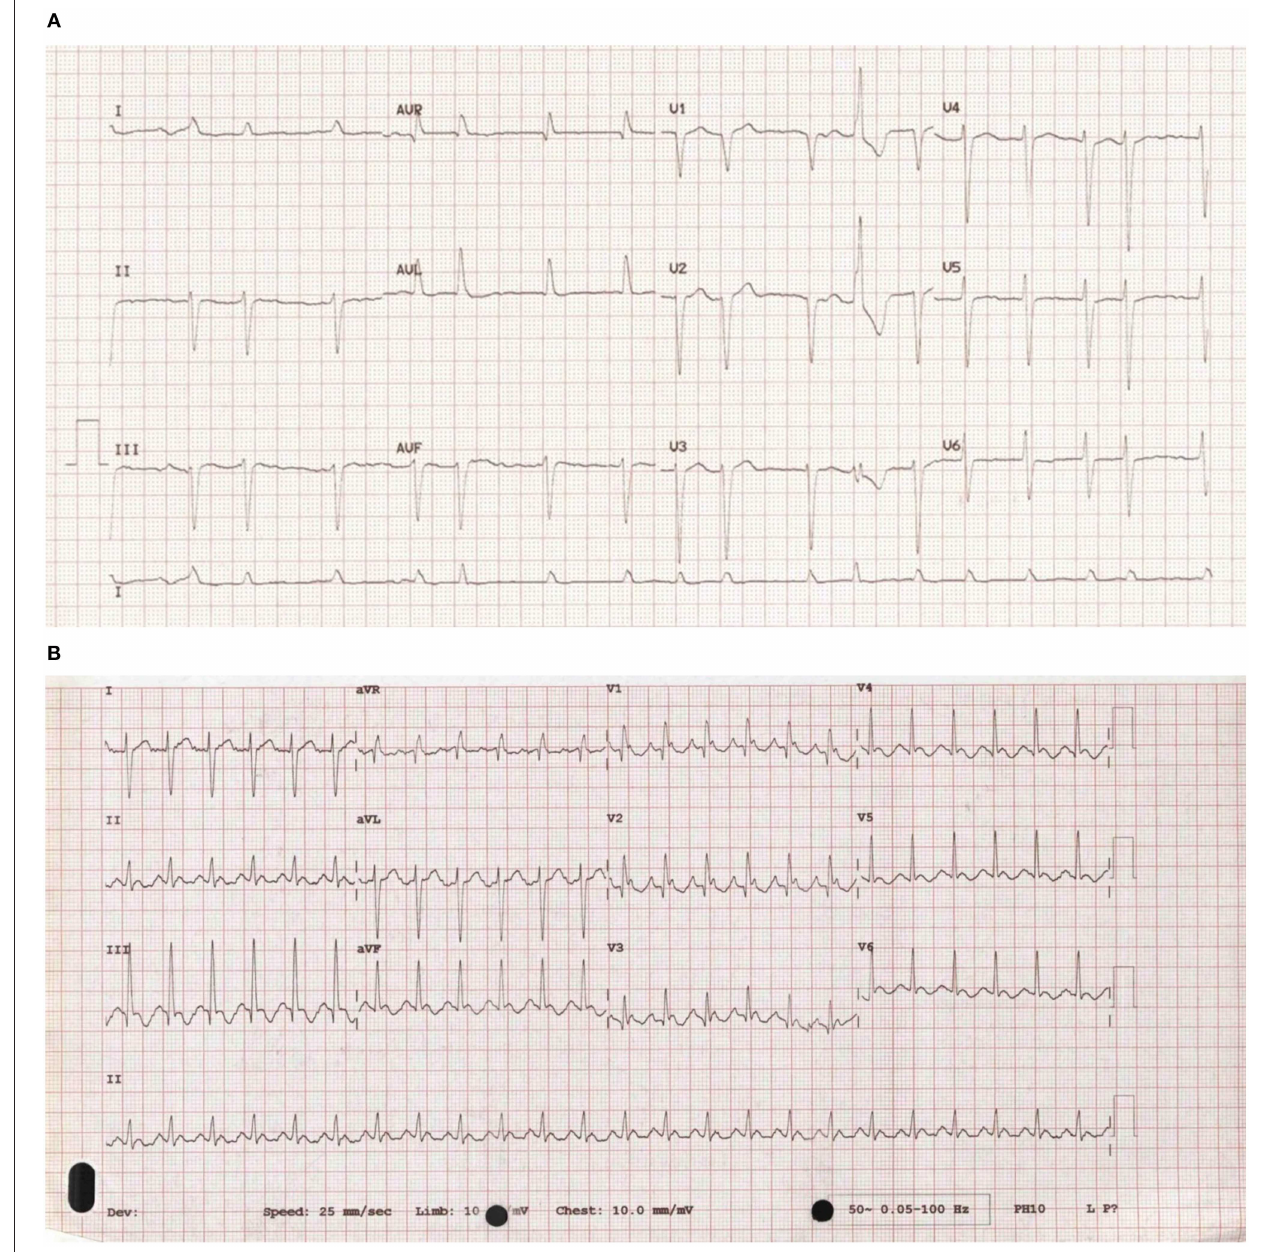
FIGURE 1 | (A) An ECG of atrial fibrillation. An example of an ECG taken from a patient with atrial fibrillation showing uncoordinated atrial activity resulting in an irregular ventricular rate. (B) An ECG of atrial flutter. An example of an ECG taken from a patient with atrial flutter. It is characterized by rapid, regular atrial depolarizations (typically, but not always at a rate of 300 bpm) resulting in a ventricular rate of 150 bpm. Time from PAH diagnosis to SVA was approximately 60 months and time from SVA diagnosis to death/transplant was